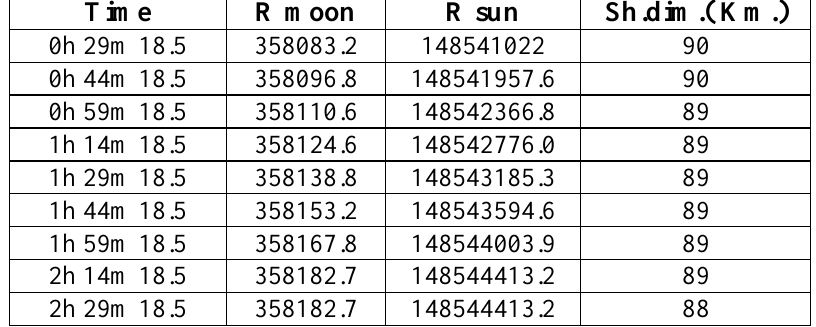
Table 2: YY = .934365429 Total CENTRAL ECLPSE